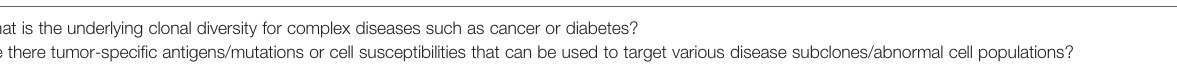
TABLE 1 | Unmet needs and addressable questions in gene and cell therapy. Prior to